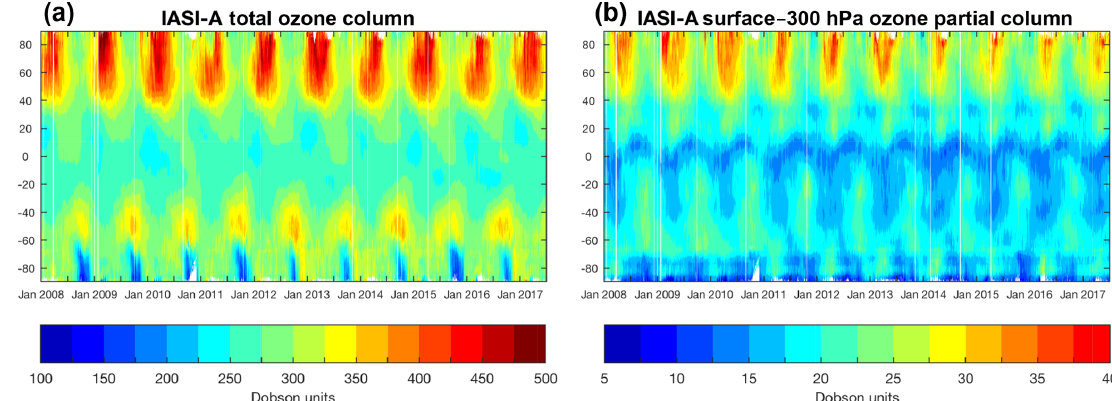
Figure 5. IASI-A total ozone column (a) and TROPO O 3 column (b) record (in Dobson units) as a function of latitude and time from January 2008 to July 2017. The TROPO O 3 column is calculated as the column integrated between the surface and 300hPa.